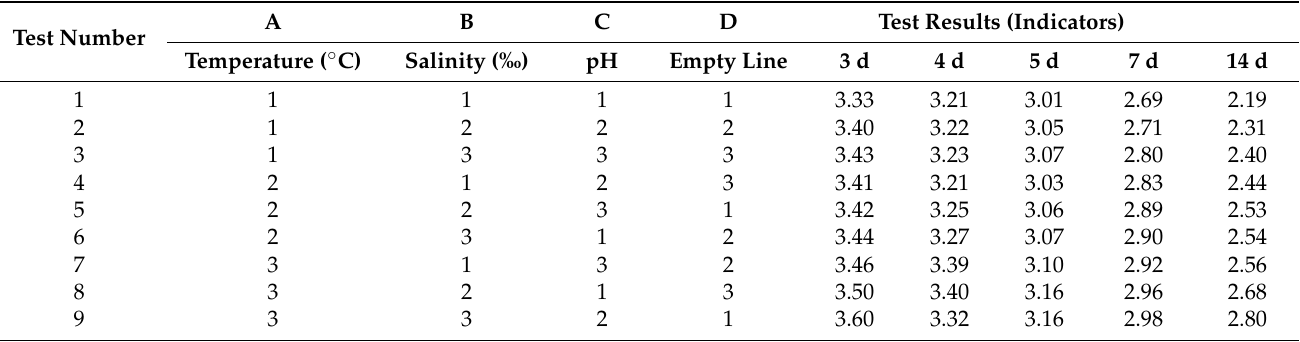
Table 5. Analysis of the range of results from the orthogonal experiment (3–14 d).